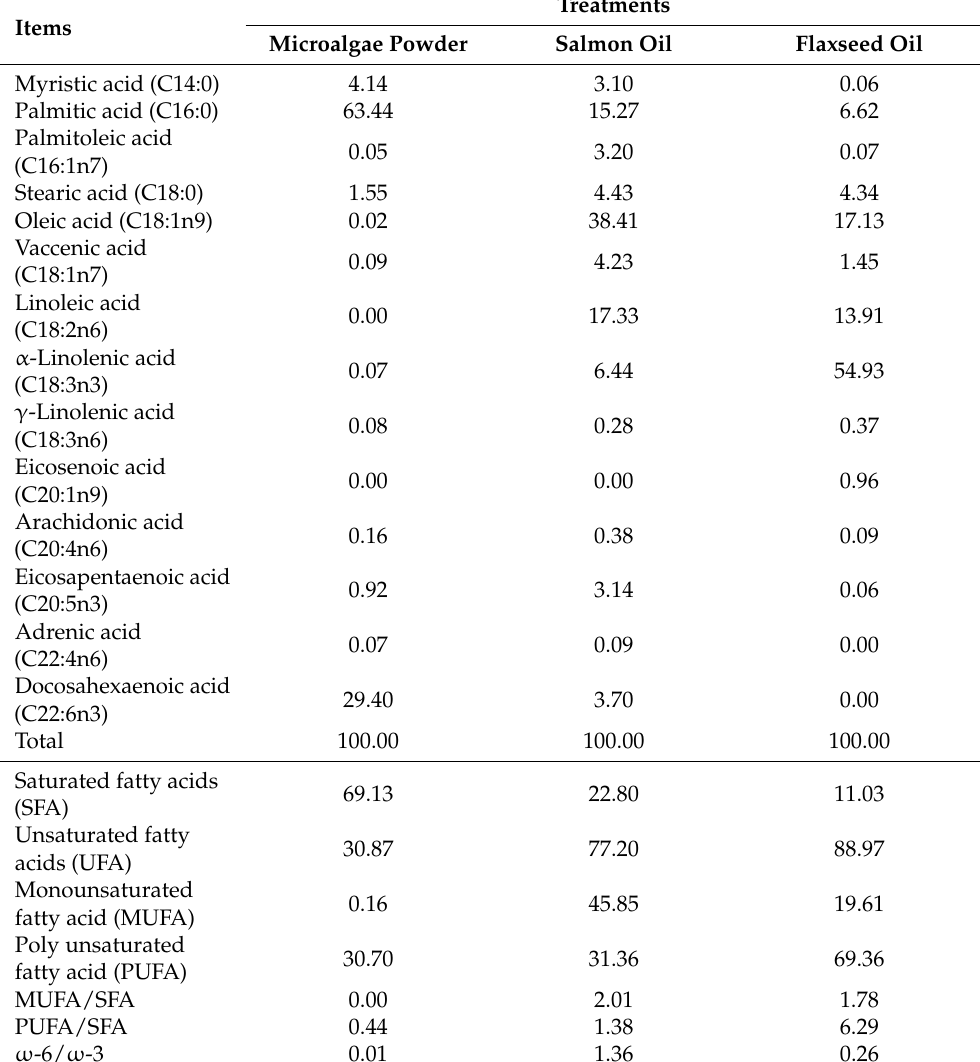
Table 2. Fatty acids contents (% of total fatty acids) of microalgae, salmon oil, and flaxseed oil.